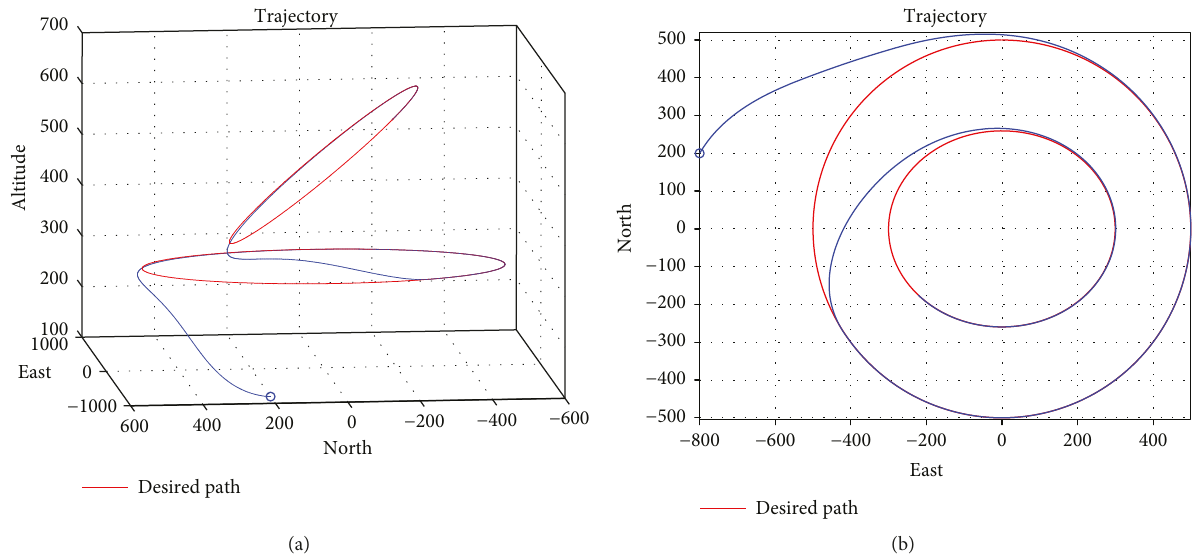
Figure 15: Circular path transition with circle radii of 500 m and 300m and inclination angles of 0 and 30 degrees, respectively. (a) Three- dimensional view, (b) planar view. Table 2: Initial conditions used in